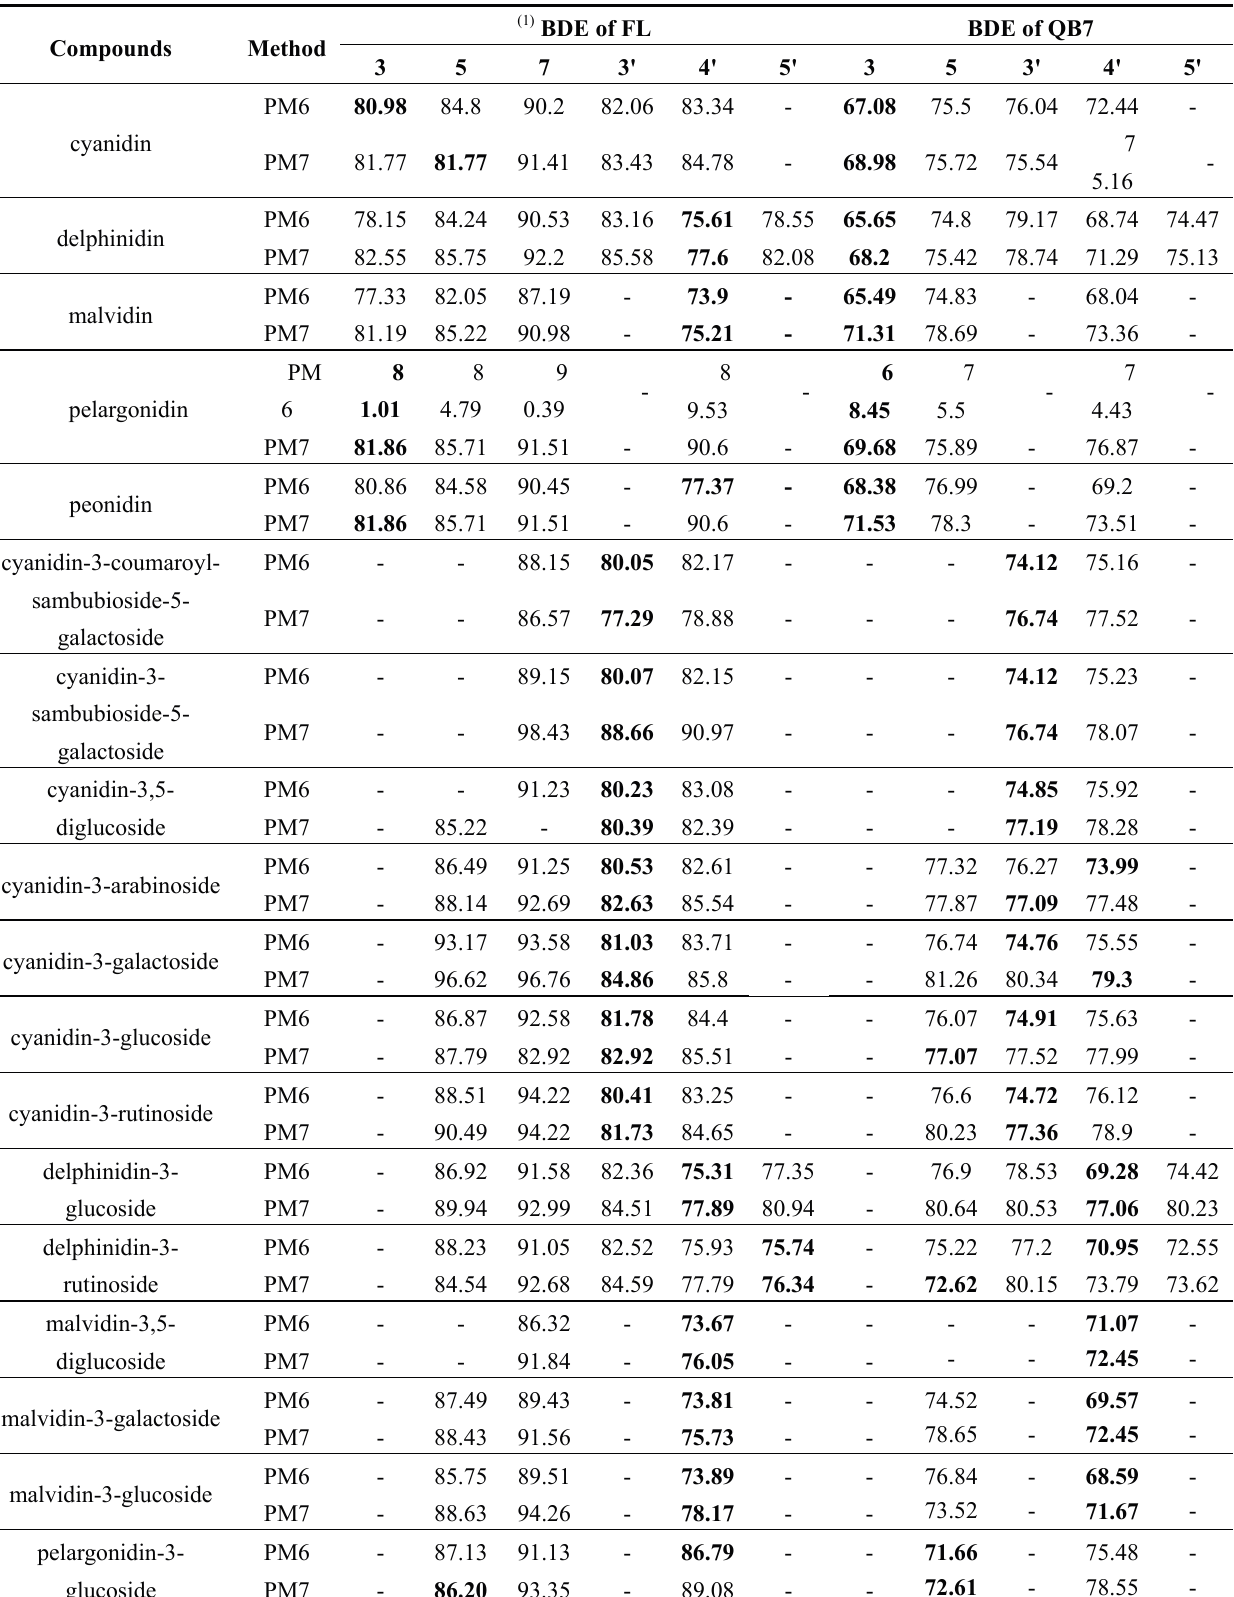
Table 2. Hydrogen atom dissociation energy of flavylium cations and quinoidal pseudo bases calculated by semi-empirical